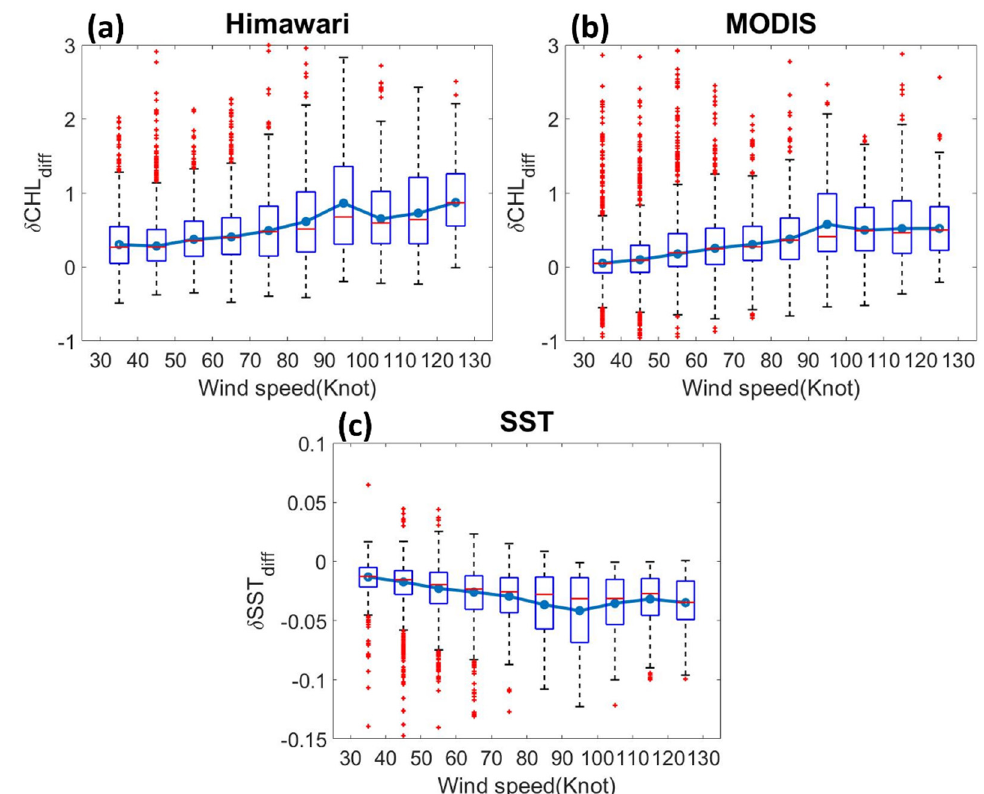
Figure 7. Typhoon-induced Chl-a changes ( δ CHL diff ) corresponding to different wind forcing strengths calculated on the basis of Equation 3 for (a) AHI and (b) MODIS composites. The change rate of SST ( δ SST diff ) corresponding to different wind forcing is shown in (c). The lowest and highest sides of the blue rectangles denote the lower quartile (25th percentile) and upper quartile (75th percentile), respectively. The red line in the rectangles denotes the median. The minimum and maximum bars denote the lower quartile − 1.5 × IQR and upper quartile +1.5 × IQR , respectively, where IQR denotes the upper quartile–lower quartile. The red plus signs denote the outliers. Light blue lines connect the means of each interval removing